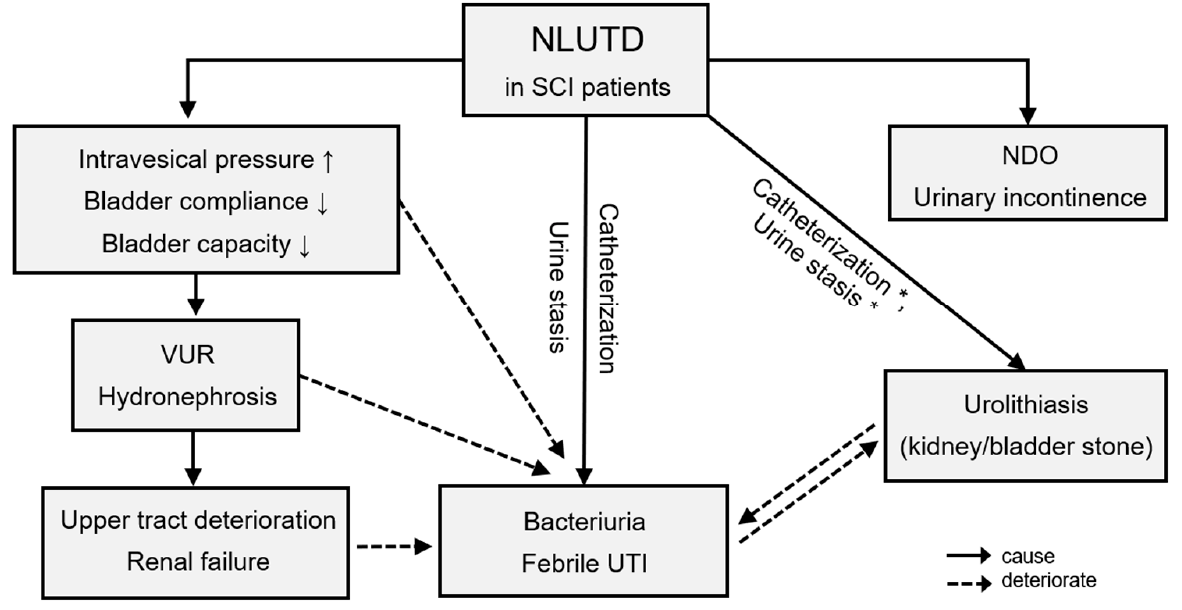
Figure 1. Urological complications in chronic spinal cord injury patients. * Catheterization and urine stasis were mainly related to bladder stones. Abbreviations: SCI, spinal cord injury; NLUTD, neurogenic lower urinary tract dysfunction; VUR, vesicoureteral reflux; NDO, neurogenic detrusor overactivity; UTI, urinary tract infection.